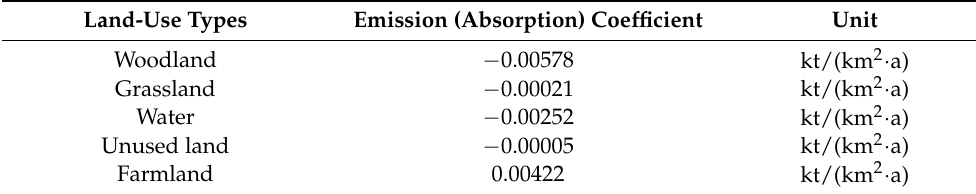
Table 1. Emission (absorption) coefficient of the five types of land use studied in Henan. Land-Use Types Emission (Absorption) Coefficient Unit Woodland − 0.00578 kt/(km 2 · a) Grassland − 0.00021 kt/(km 2 · a) Water − 0.00252 kt/(km 2 · a) Unused land − 0.00005 kt/(km 2 · a) Farmland 0.00422 kt/(km 2 · a)